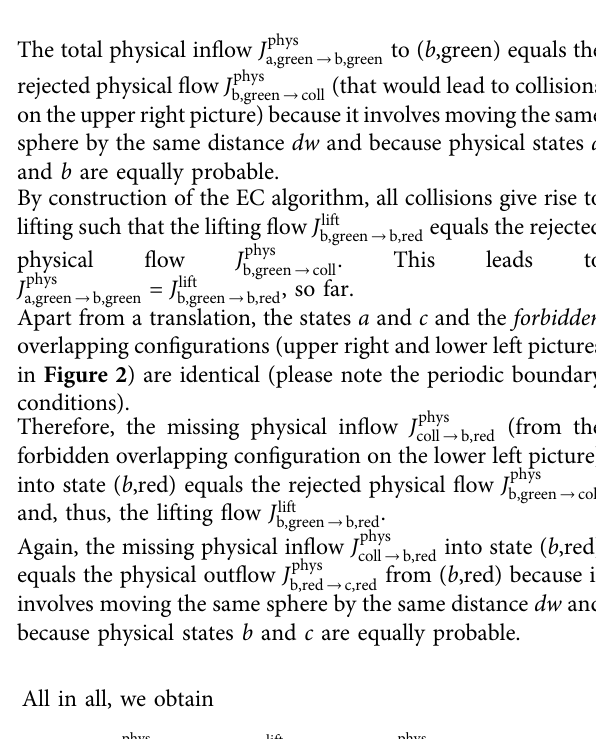
Frontiers in Physics |